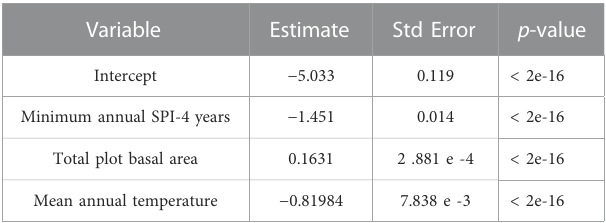
TABLE 2 Generalized linear quasi-binomial model fi tto predictlive carbon loss in ponderosa pine ( Pinus ponderosa )